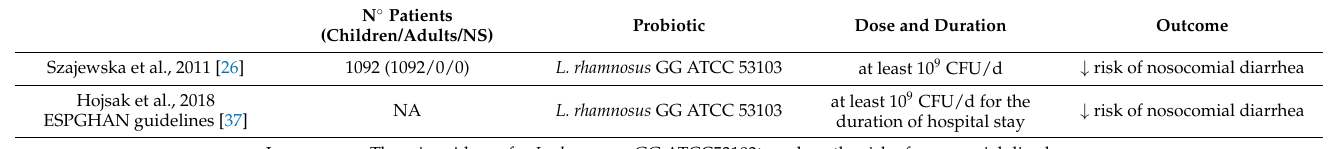
Table 5. Meta-analyses and systematic reviews on probiotics in nosocomial diarrhea. N ◦ Patients